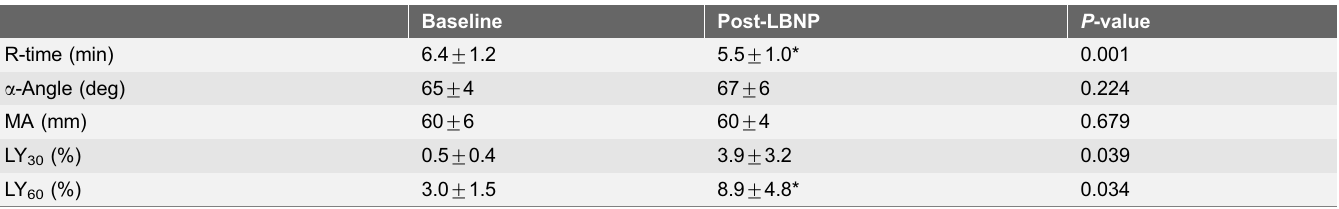
Table 2. Whole blood coagulation competence determined by thrombelastography before and 5 min after lower body negative pressure (post-LBNP) was ceased because of presyncopal symptoms.